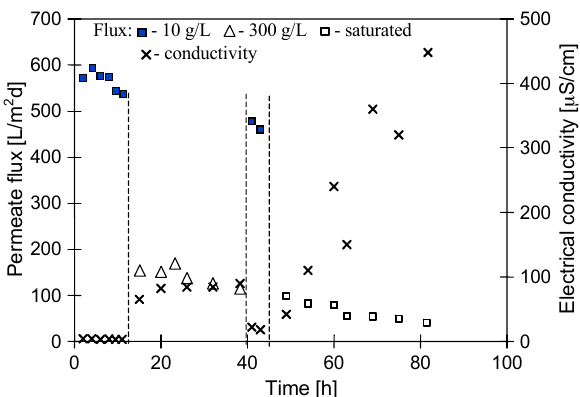
Figure 3. Changes of the permeate flux and distillate electrical conductivity during MD of NaCl solutions. Feed initial concentration: 10 g/L, 300 g/L and saturated (at 293 K) solution. Module MD1.